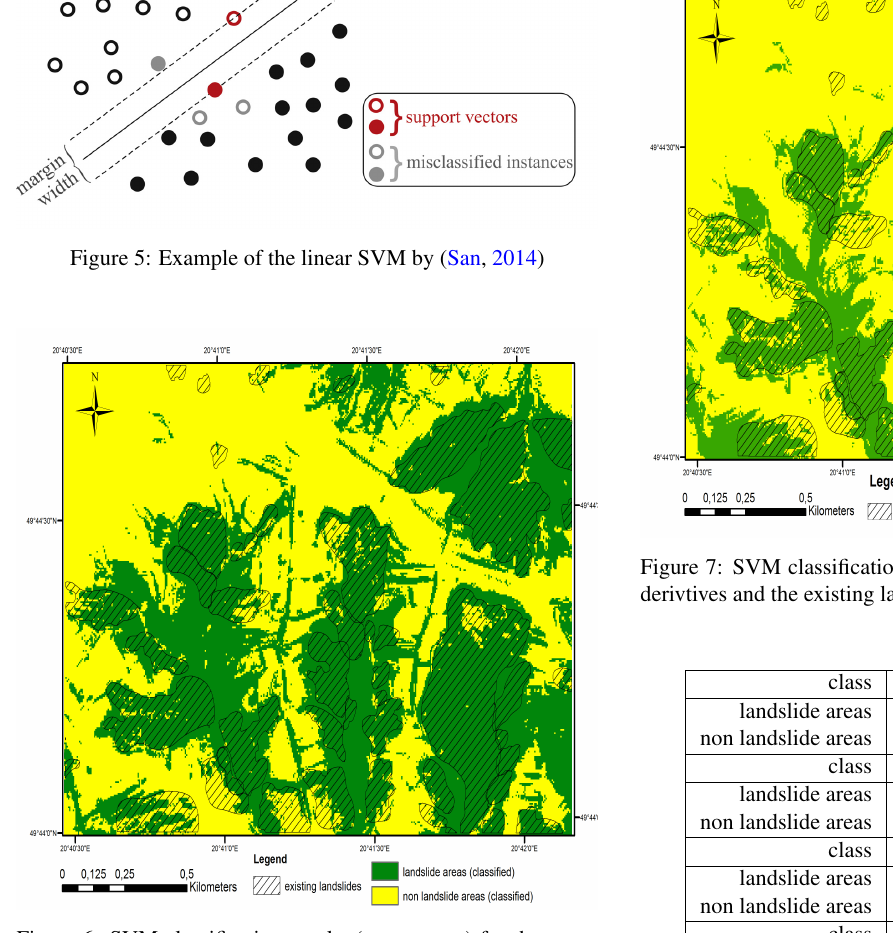
Figure 6: SVM classification results (green areas) for the seven PCA components and the existing landslides (hatched polygons)